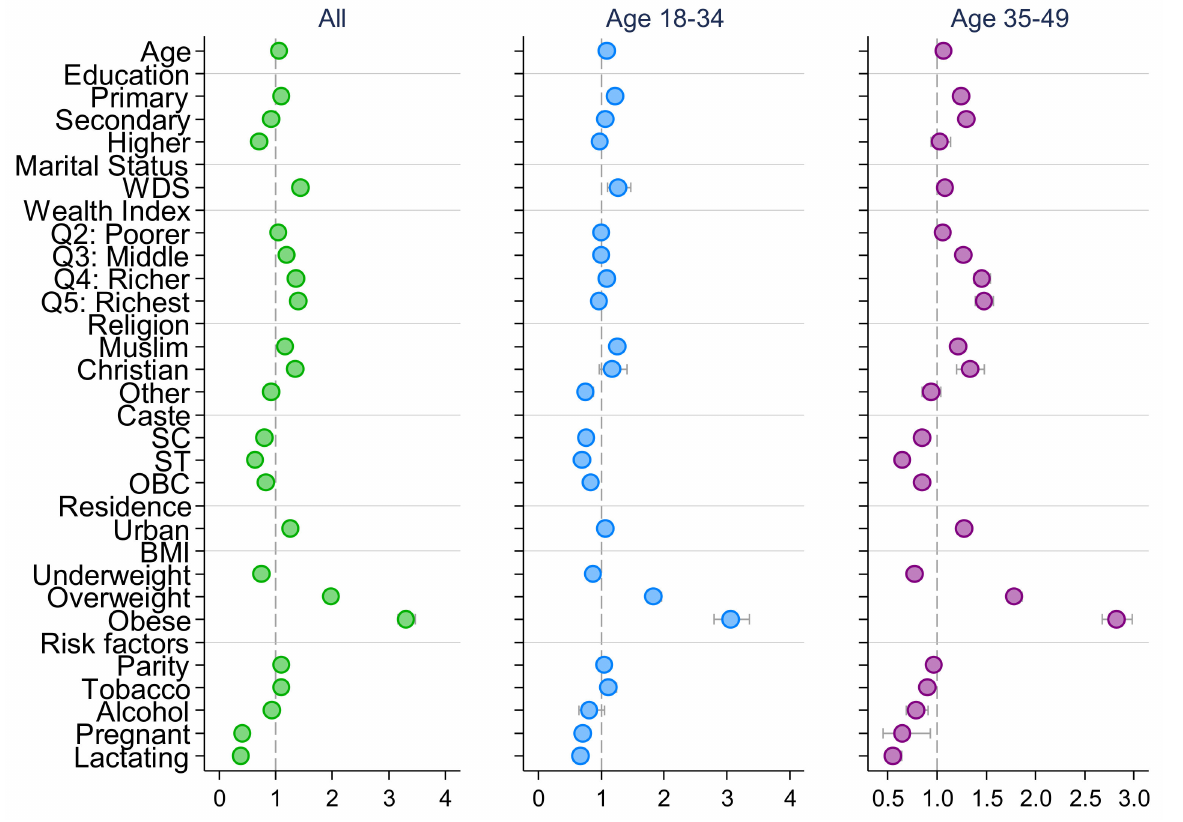
Figure 4. Crude odds ratios in favor of having high blood glucose for the covariates. Estimates were obtained using complex survey weights. The horizontal lines across the markers represent 95% confidence intervals. The base categories of each categorical variable are as follows: educational attainment—no education; marital status—married; religion—Hindu; caste—none; wealth index quintiles—Q1: poorest; residence—rural; and BMI—normal. Table 2. Crude odds ratios in favor of having high blood pressure and high blood glucose by age at marriage. High Blood Pressure 1 High Blood Glucose